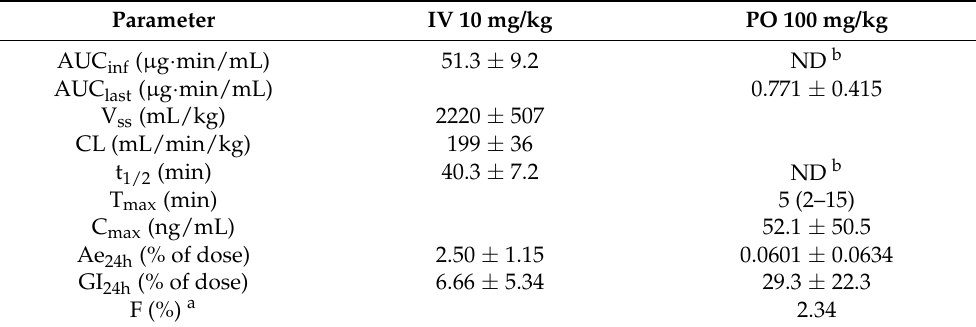
Table 3. Pharmacokinetic parameters of acacetin following intravenous administration at a dose of 10 mg/kg and oral administration at a dose 100 mg/kg in rats ( n = 3–4).